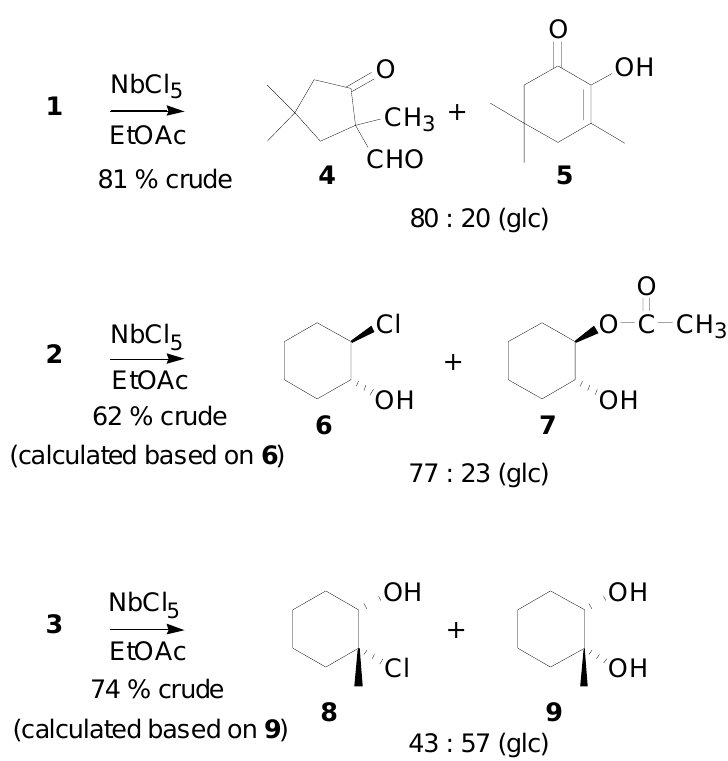
Scheme 1. Results obtained on treatment of epoxides with NbCl using ethyl acetate as